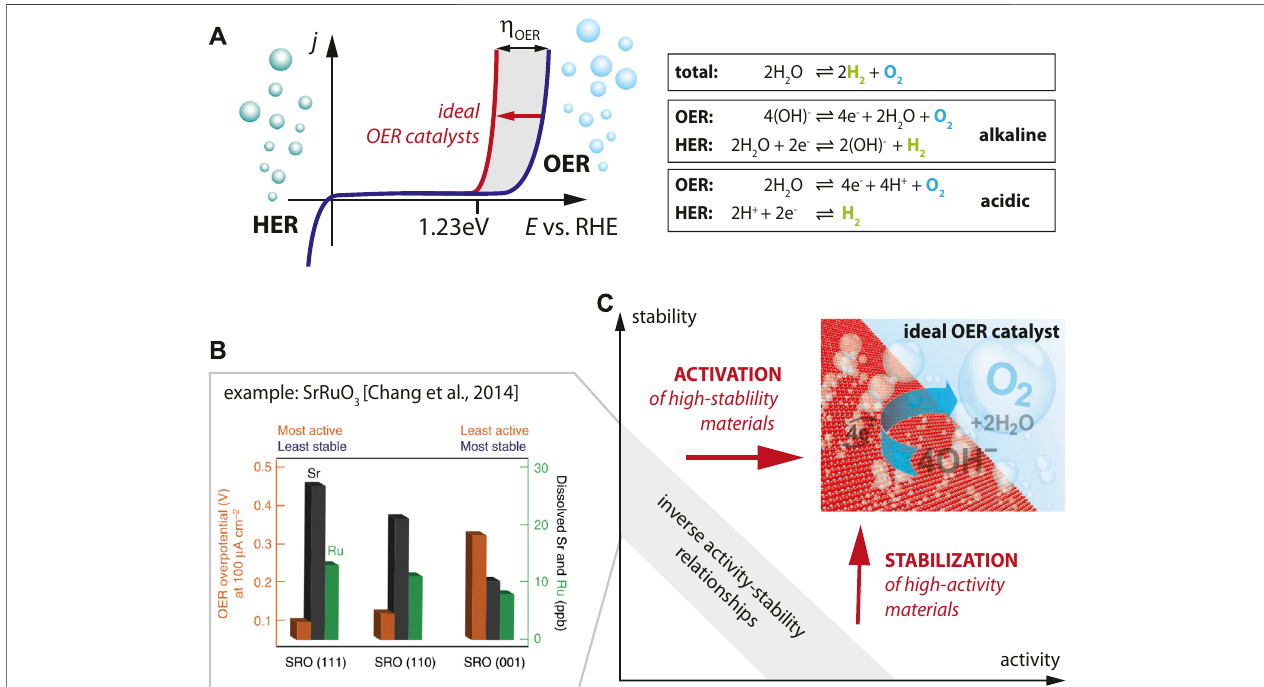
FIGURE 1 | (A) The water splitting reaction in liquid electrolyte illustrating the two half-reactions of hydrogen evolution reaction and oxygen evolution reaction for alkalineandacidicmedia.Schematicbehaviorforideal(red)andreal(blue)OERcatalysts. (B) EnhancedcationdissolutionofSrandRuionsfromSrRuO 3 thin fi lmsforthe most active crystal facets(111) [Reprinted bypermissionfrom Springer Nature, Nature Commun., Functional links between stability and reactivity ofstrontium ruthenate single crystals during oxygen evolution, Chang et al., 2014]. The inverse relation of chemical dissolution and required overpotential illustrates the inverse stability- activityrelationshipofstandardOERcatalysts. (C) MaterialsdesignstrategiesareneededtoactivateandstabilizeOERcatalystsinordertoovercomethestability-activity